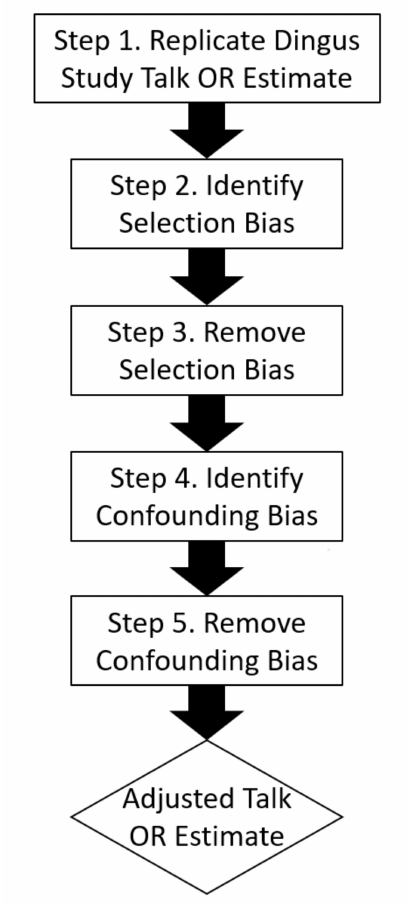
Figure 1. Method flow